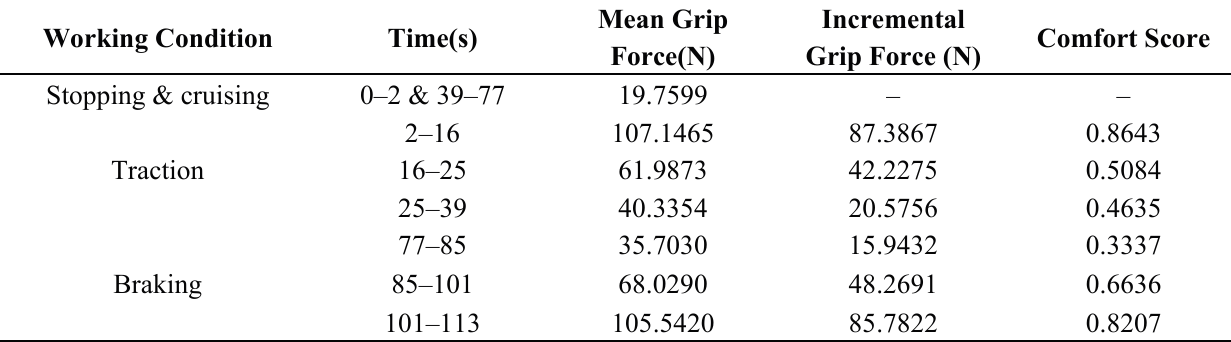
Table 8. The grip forces and the comfort scores of the